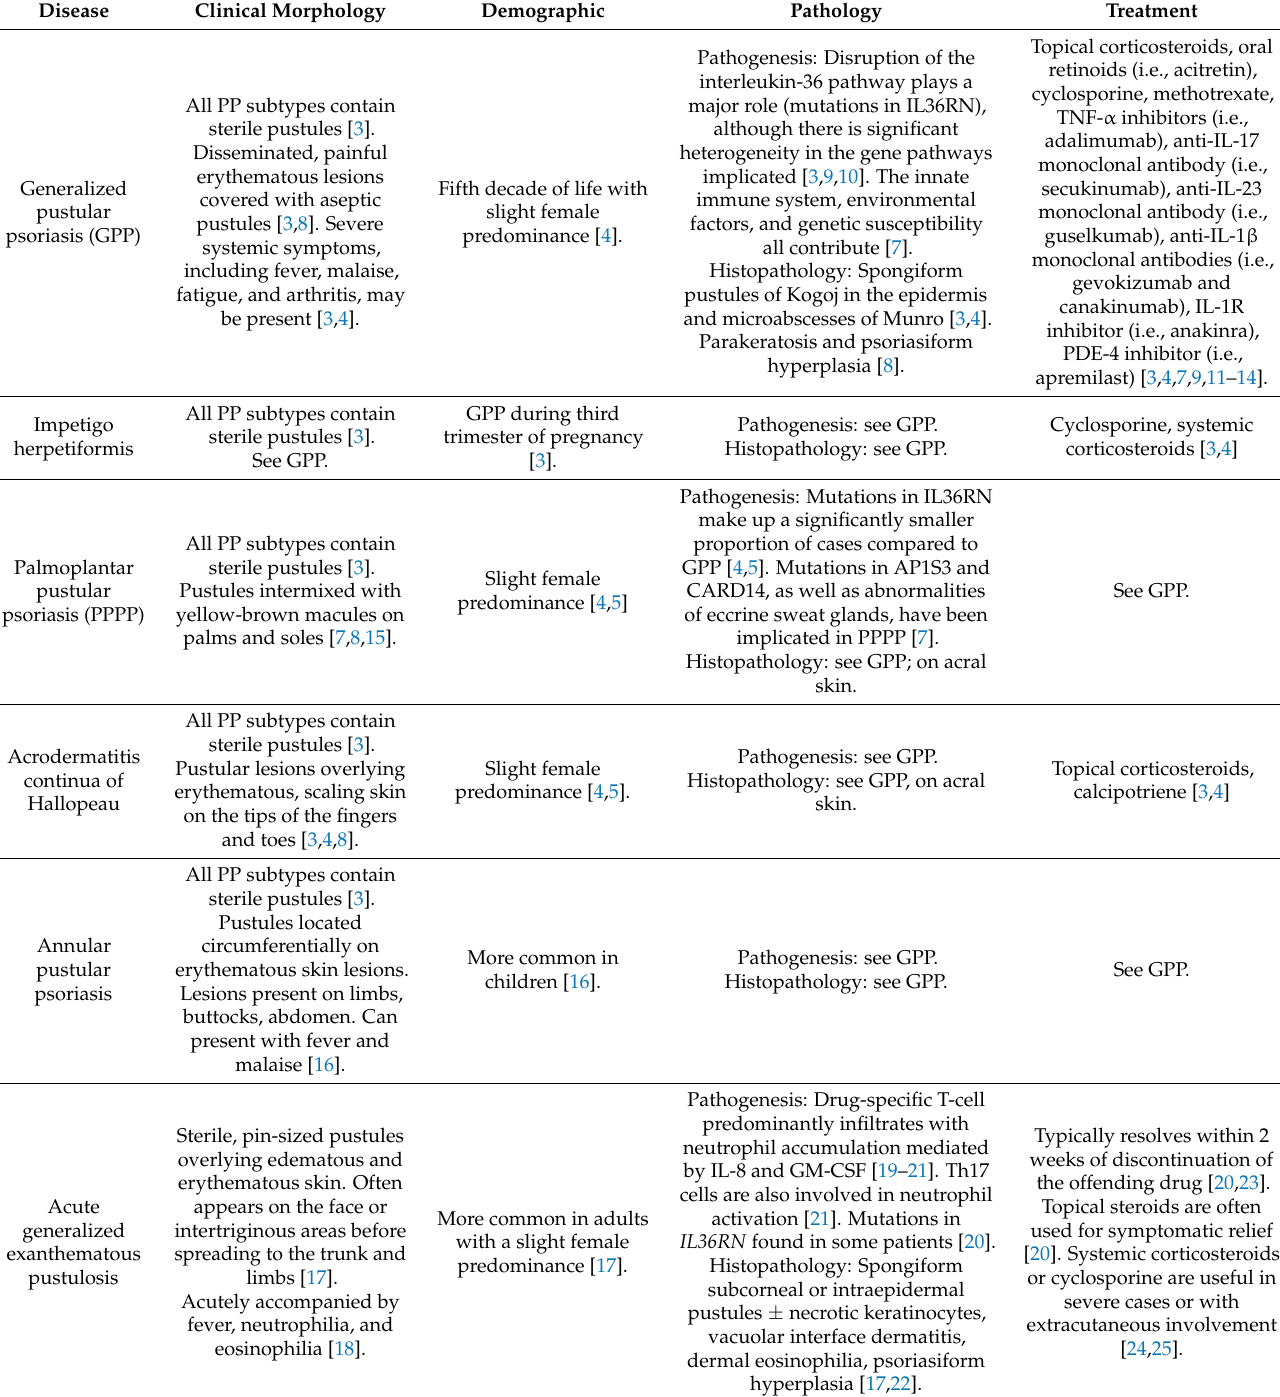
Table 1. Features of pustular psoriasis variants and acute generalized exanthematous